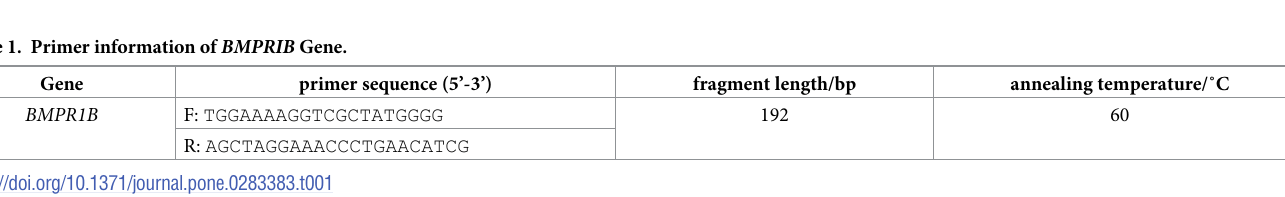
design primers for the obtained full-length sequence of the BMPR1B . The primer information is shown in Table 1. All primers were synthesized by the Shanghai (China) Sheng gong Bioen- gineering Company.